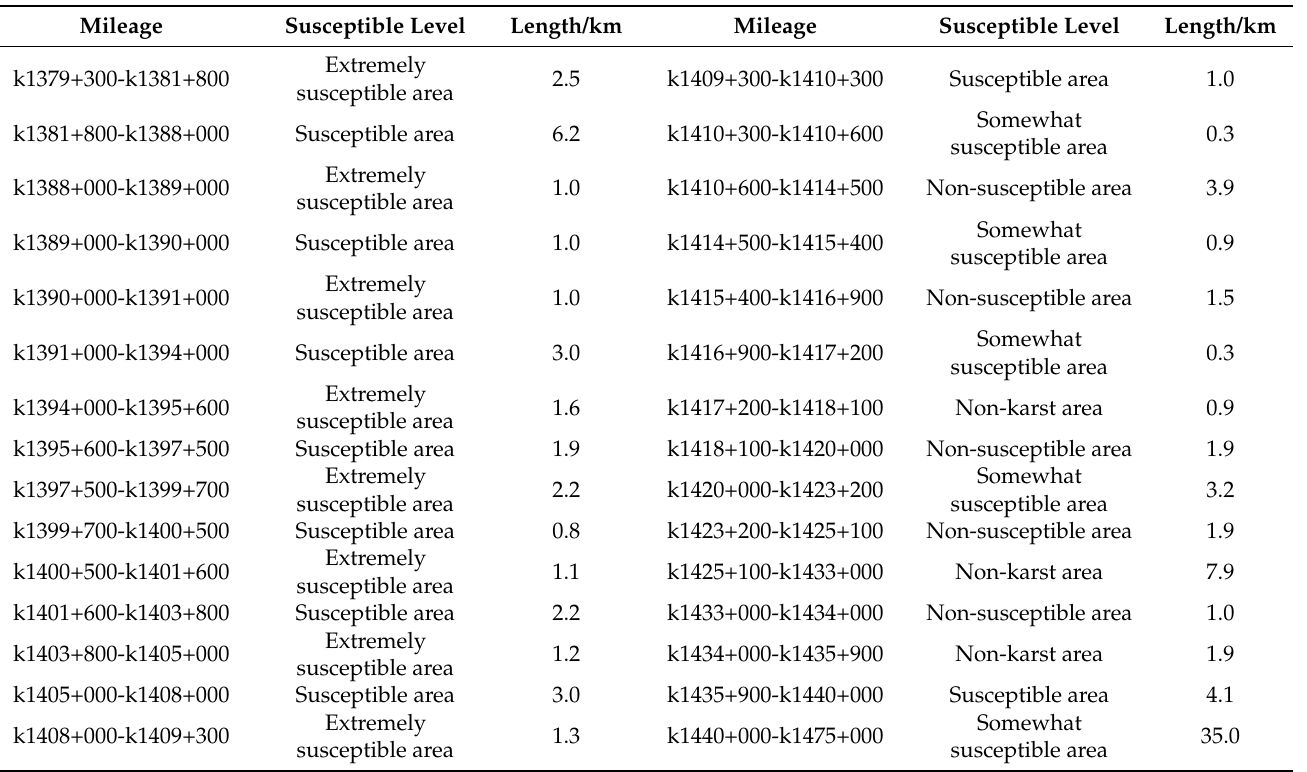
Table 7. Table of evaluation conclusions of karst collapse